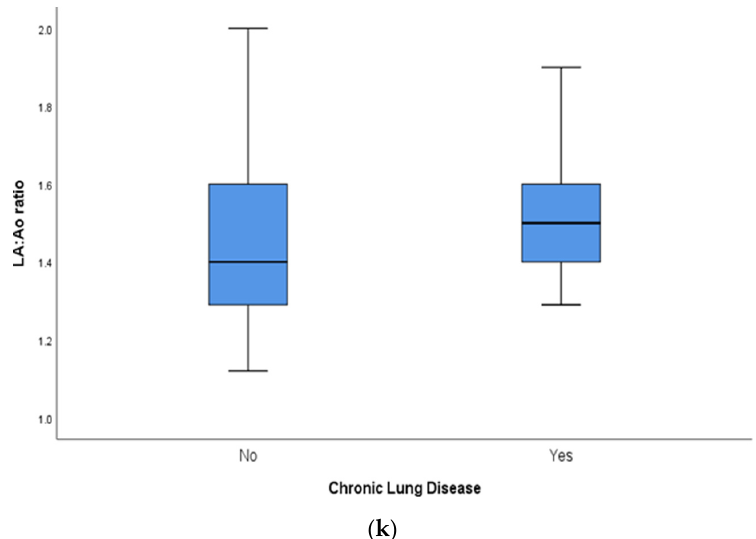
Figure 1. Comparison of echocardiography measurements in infants with and without CLD/death.